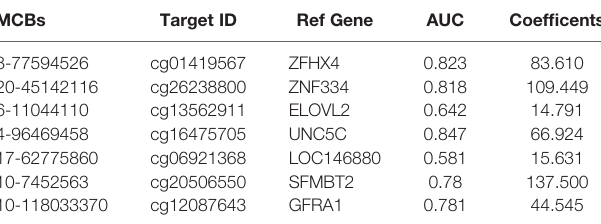
TABLE 2 | Characteristics of the seven methylation markers and their coef fi cients in diagnosis.